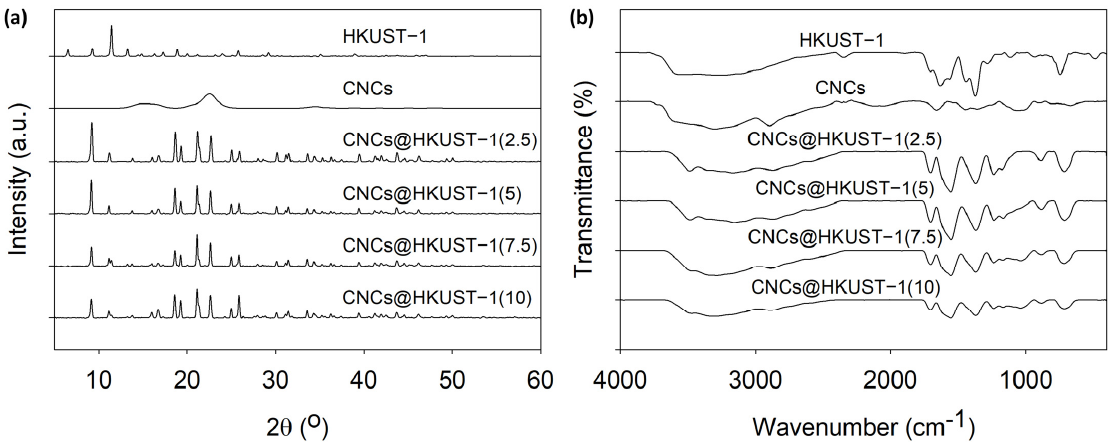
Figure 2. ( a ) XRD diffractogram and ( b ) FTIR spectra of CNCs, HKUST-1, and CNCs@HKUST-1 composites.